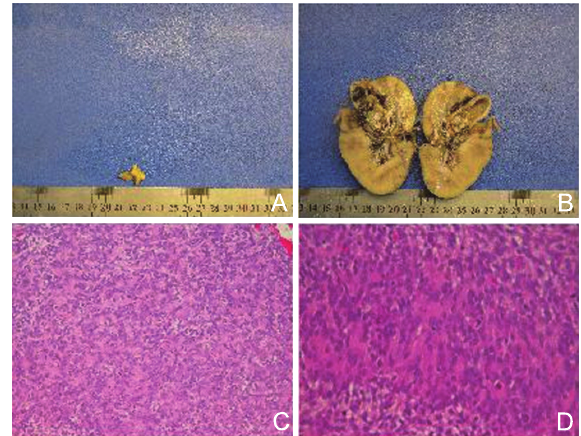
Figure 7 The gross specimen and histological results. (A~B) The gross specimen. (A) The renal hilar lymph node. B The right kidney with the tumor. We can see the gray kidney tissue and inner mass contained both cystic and solid component. (C~D) Histological examination showed clear cell sarcoma of right kidney, with lymph node reactive hyperplasia of renal hilar but no metastasis. (C Dyeing: HE ×20. D Dyeing: HE